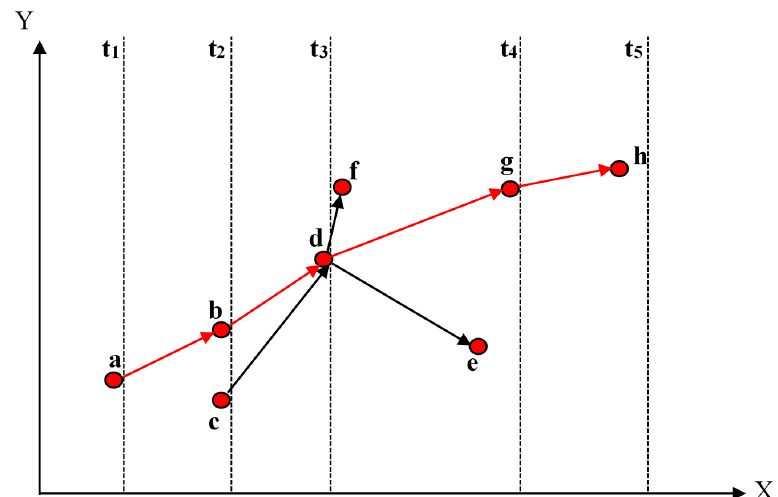
Figure 4. A graph representation showing the life cycle of a thunderstorm. The red polyline is the simplification of the graph representation using the maximum reflectivity path.